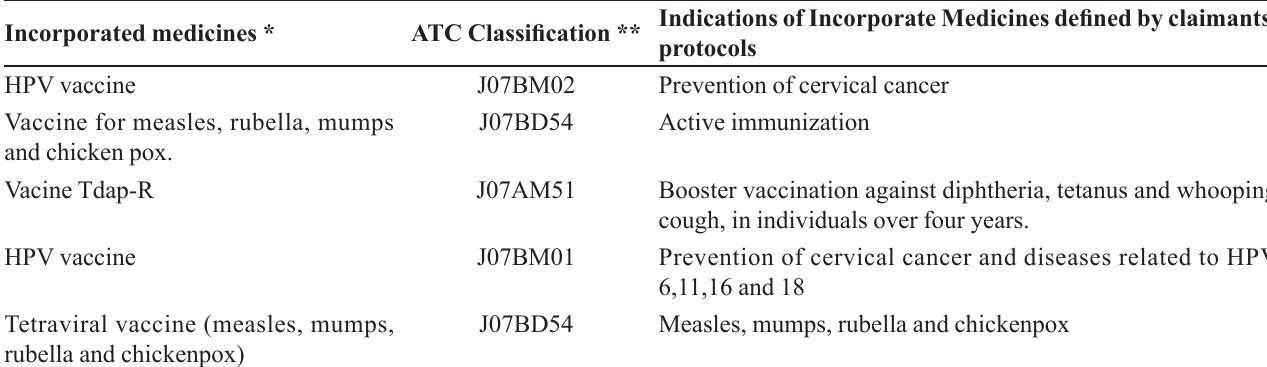
TABLE III - List of medicines incorporated by CONITEC with the respective 5 th level ATC classification and its indications to the National List of Essential Medicines (RENAME). January 2012 - July 2015, Brazil (cont.)